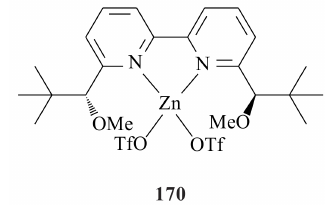
Figure 38. Chiral Zn-bipyridinyl complex.